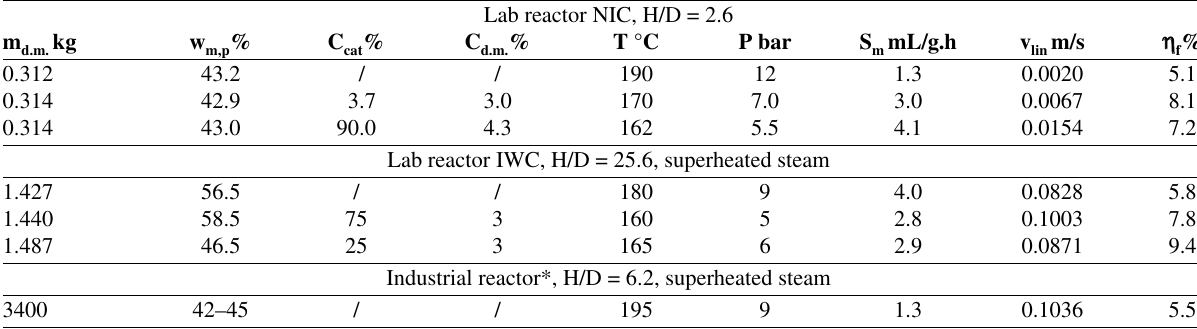
Table 4. Comparison of operating parameters and results for few non-catalysed and catalysed experiments carried out at NIC, IWC and industrial production data. Lab reactor NIC, H/D =